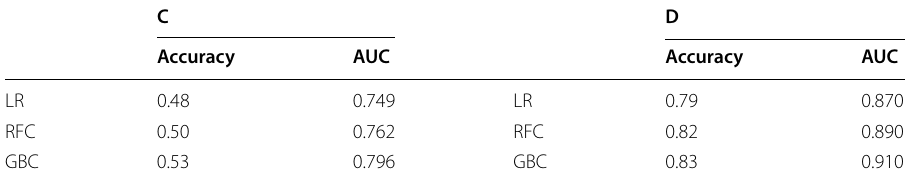
Table 7 Classification models results of accuracy and area under the curve for Current Income